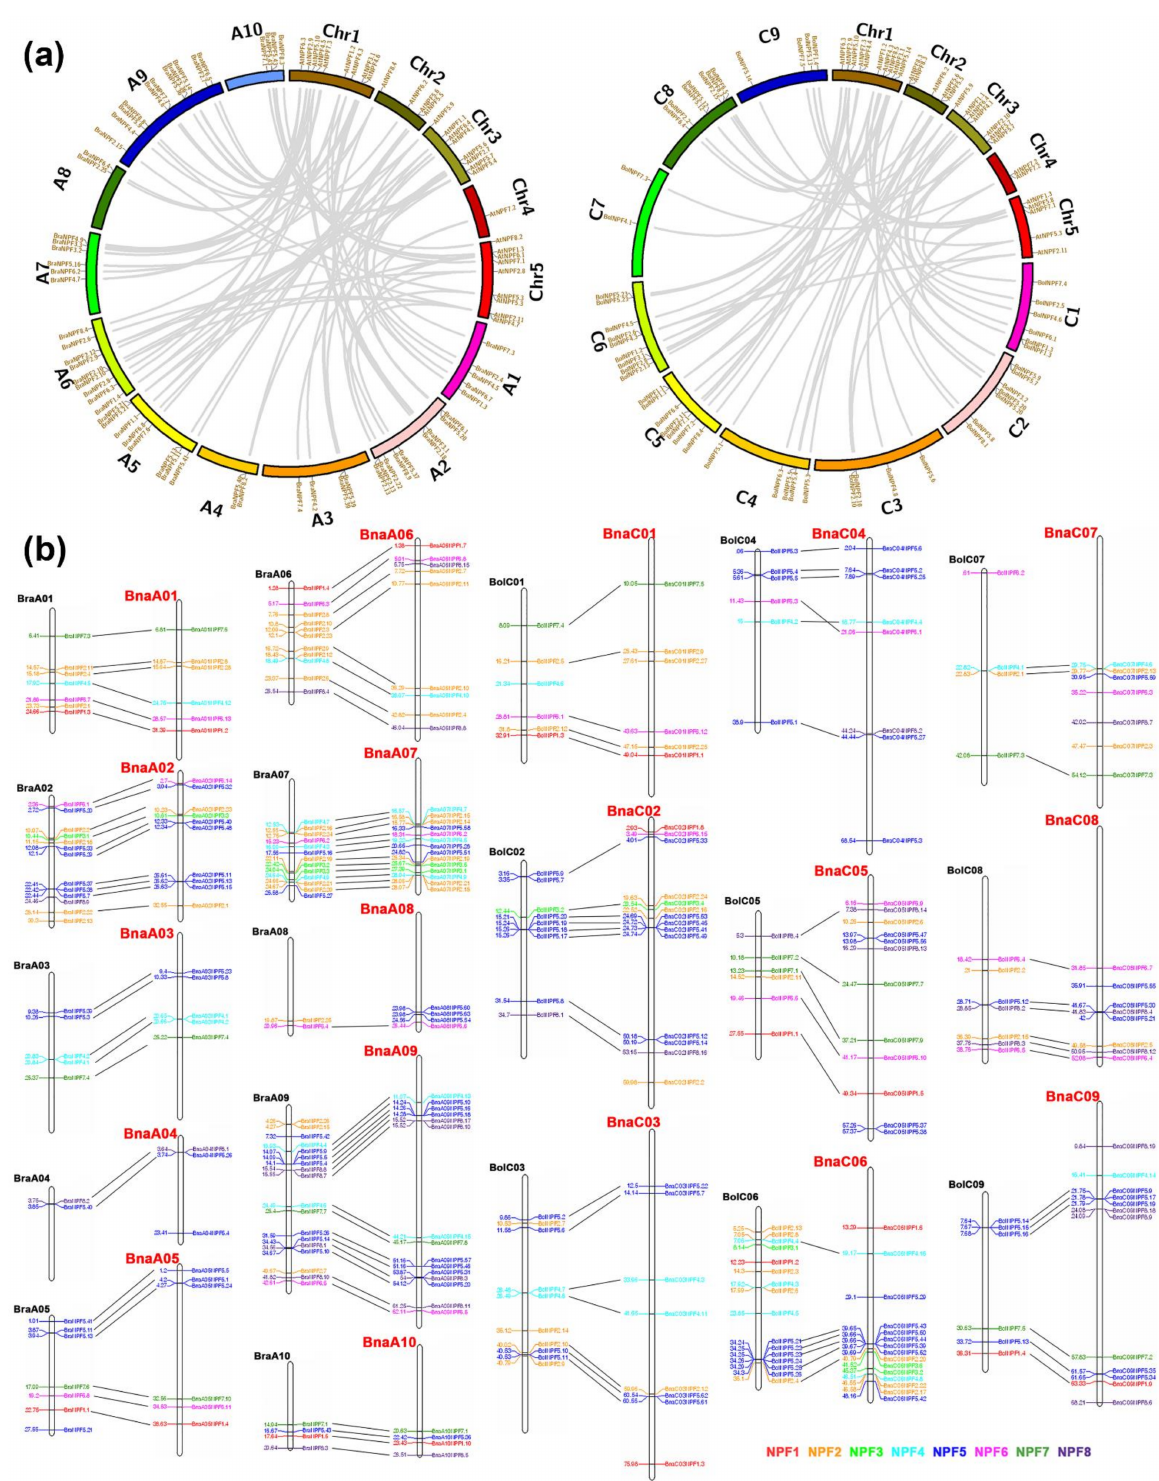
Figure 1. Genomic distribution of the NPF genes in Arabidopsis , B. rapa , B. oleracea and B. napus , and synteny of the NPF genes in the four Brassica species genomes. ( a ) The synteny of NPF genes between Arabidopsis and B. rapa ( Left ), and between Arabidopsis and B. oleracea ( Right ). ( b ) The collinearity of NPF genes between B. rapa and the A sub-genome of B. napus , and between B. oleracea and the C sub-genome of B. napus . Three letters before the chromosome were used to distinguish the species, and the color of the font on the bottom right distinguishes the